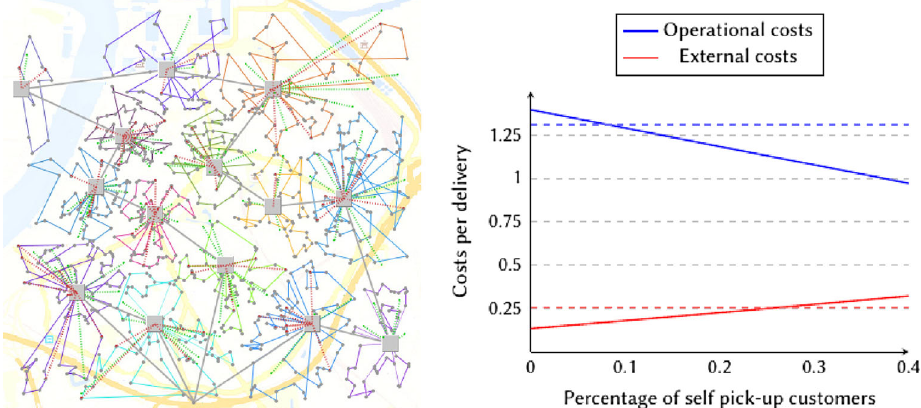
Fig. 6 (left) Parcel distribution via cargo bikes with additional DPs and self-pick-up. (right) Costs per delivery for a varying number of self-pick-up customers, compared to traditional home delivery (dashed